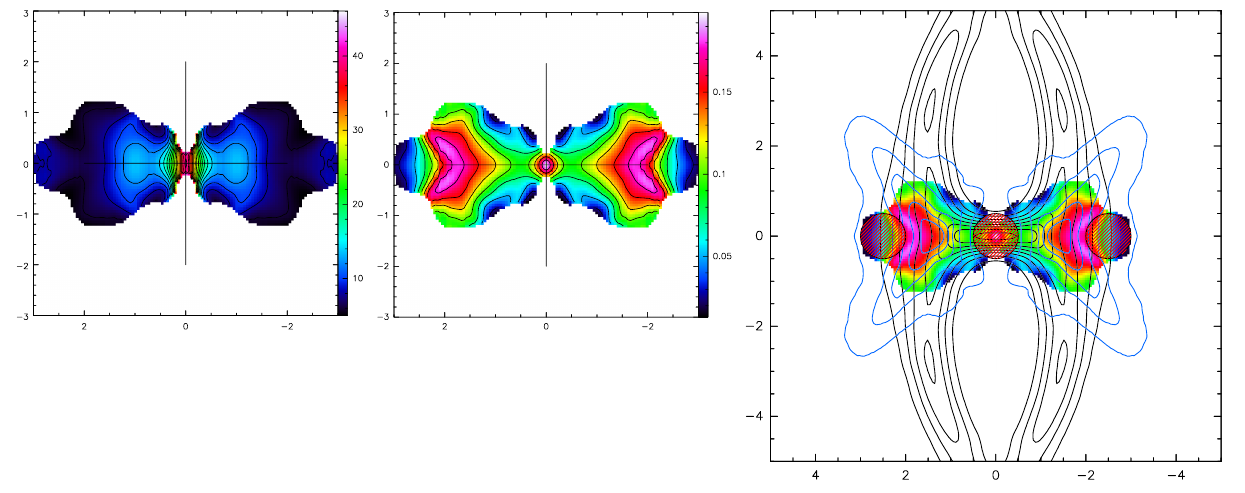
Figure 3. Results from the rotational diagram fitting for SO. On the left, a plot of the resulting excitation temperature in K. On the central panel, results for the SO particle density in cm − 3 . Note that SO mainly traces two structures: a warm compact central core and a cold 3 (cid:48)(cid:48) –5 (cid:48)(cid:48) diameter detached torus. On the right panel, comparison of the SO structure with other tracers: black contours, 13 CO brightness as in Figure 2 left; deep blue contours, the brightness of the 1667MHzOH masers by Seaquist, Plume and Davis [19] after applying the 3D-image reconstruction explained in Section 3; the red hatched circles show the location and approximate size of the central component and detached torus seen in the continuum observations at 2 and